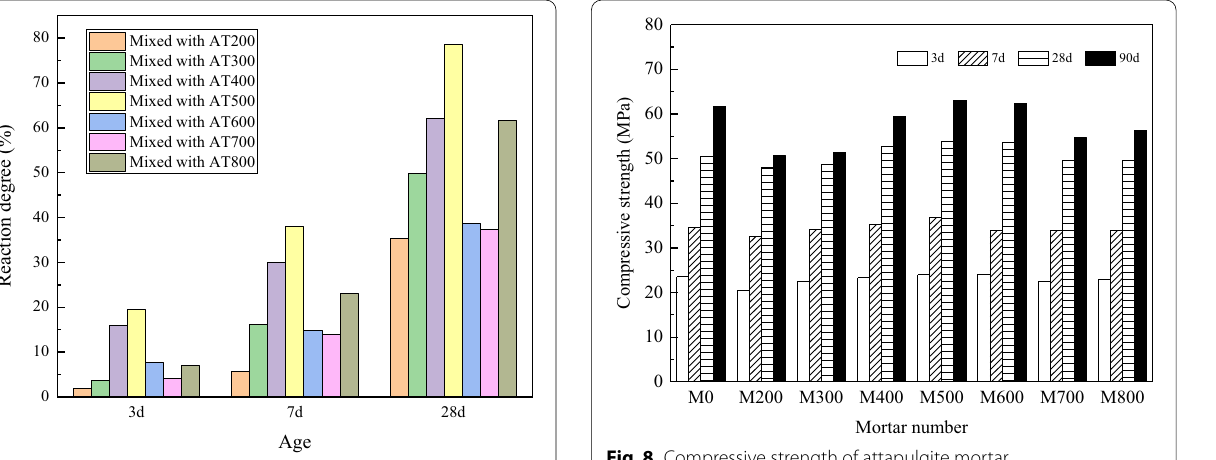
Fig. 7 Reaction degree table of attapulgite at different ages.